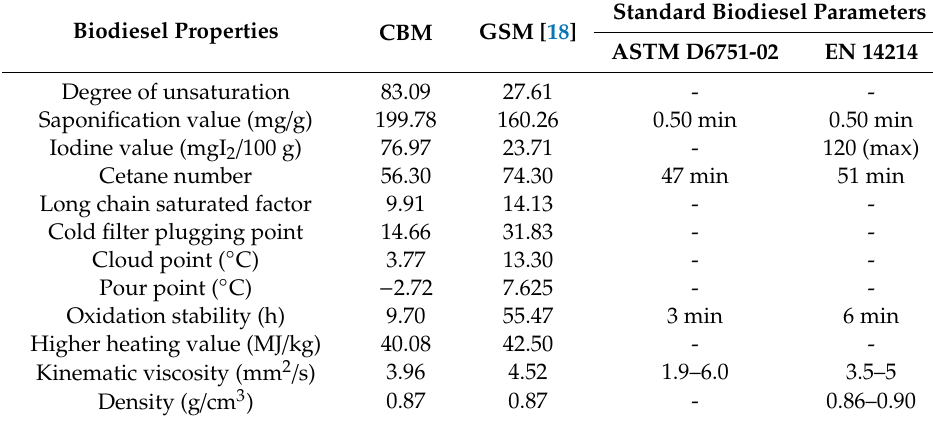
Table 2. Theoretical estimation of biodiesel properties from the CBM-cultivated